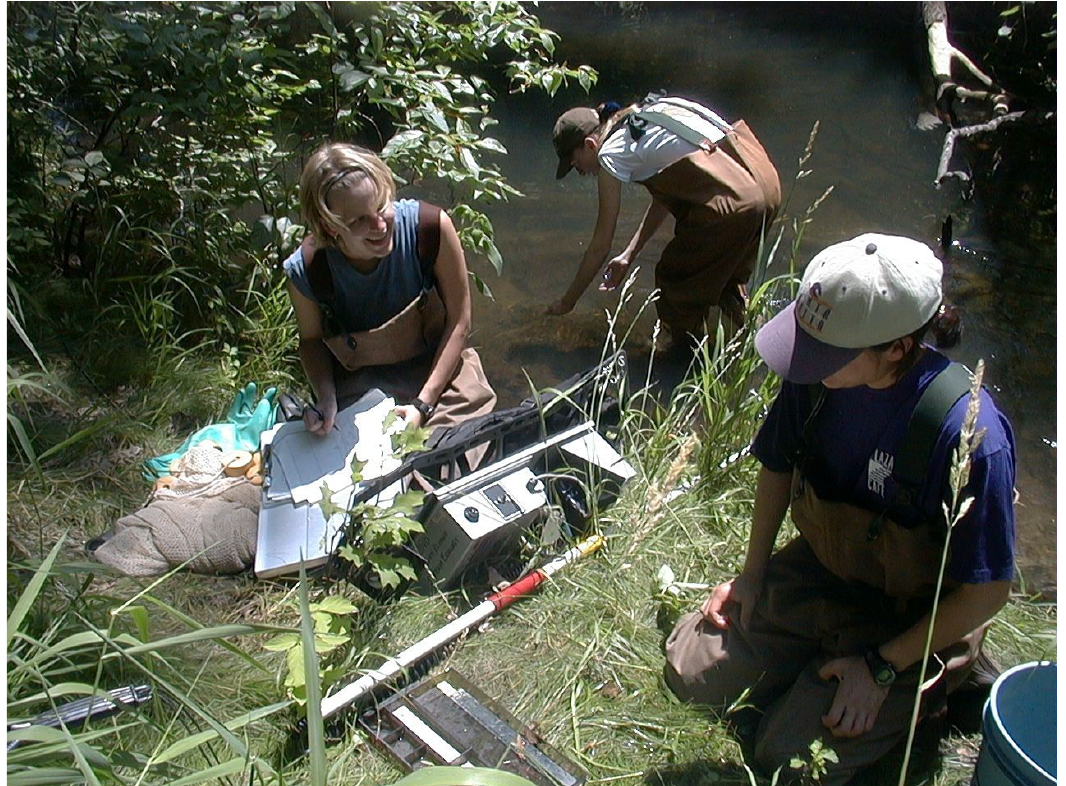
Figure A1.2. Electrofishing crew processing fish on June 26, 2001 with Ashley Moerke taking notes, Amy (Noel) Smith releasing a fish and Asako Yamamuro ready to measure another fish in